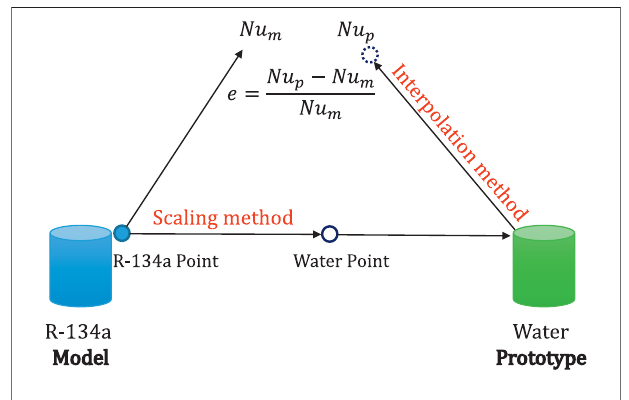
FIGURE 2 | Scaling methods optimization procedure.